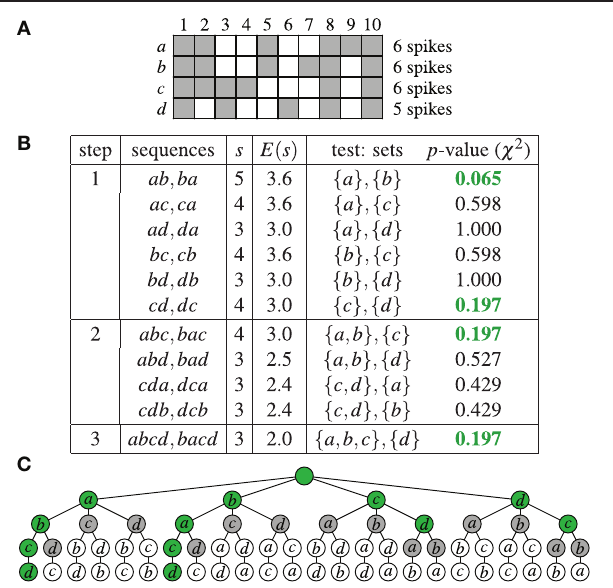
in 10 time bins. A gray square indicates the presence of a spike in an time bin. (B) Accretion for the data shown in (A) for a significance level α = 0 . 2. Column s states the actual, column E ( s ) the expected number of joint spiking events under independence. The p -values shown in green are significant. (C) Graphical representation of the process shown in (B) in the search space. Selected paths are marked in